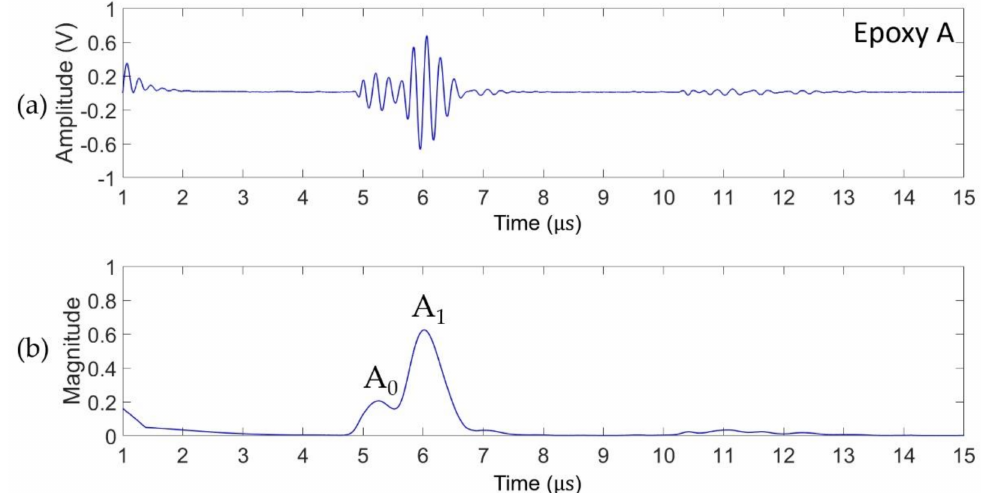
Figure 6. Pulse-echo test of the epoxy A coating layer with a thickness less than 1 mm: ( a ) time– domain waveform and ( b ) the projection of the STFT of the